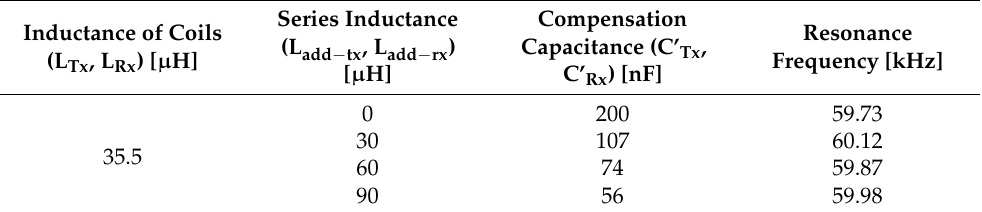
Table 12. Inductance of series inductors (L add ) and corresponding compensation capacitance values (C’ Tx , C’ Rx ).